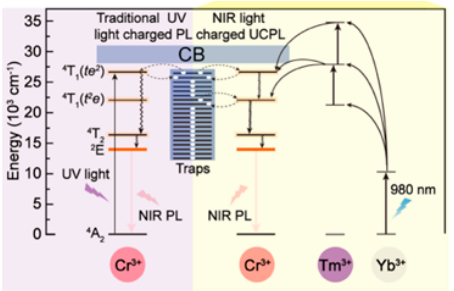
Figure 16. Energy diagram comparing the traditional UV charged PeL (left) and NIR-light-charged UCPL (right) mechanisms. Reprinted with permission from [257]. Copyright (2017) American Chemical Society.